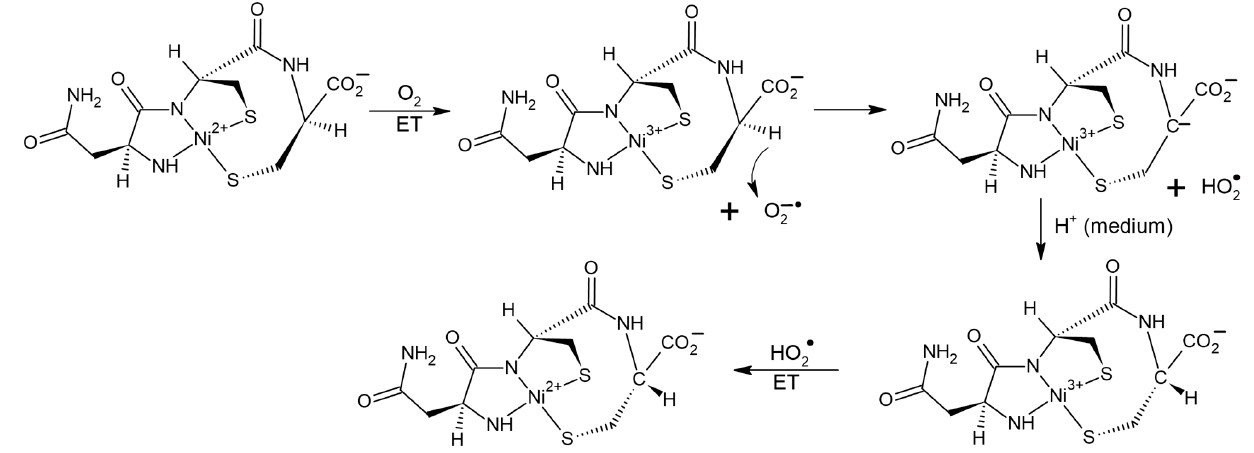
Figure 9. Proposed mechanism of chiral inversion in the Ni 2+ -asparagine-cysteine-cysteine metallo- Figure 9. ProposedmechanismofchiralinversionintheNi 2+ peptide.